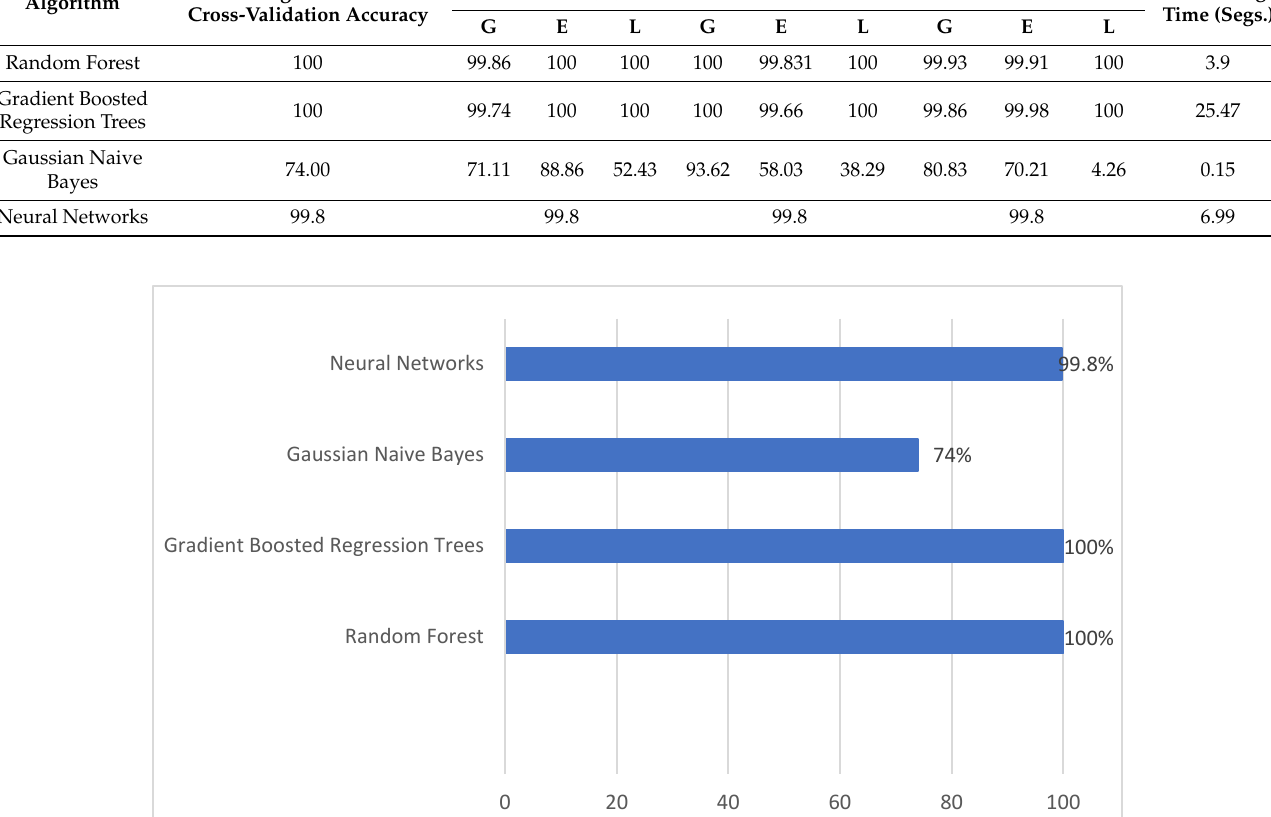
Figure 8. Ten-fold cross-validation accuracy using the dataset obtained in step 2.